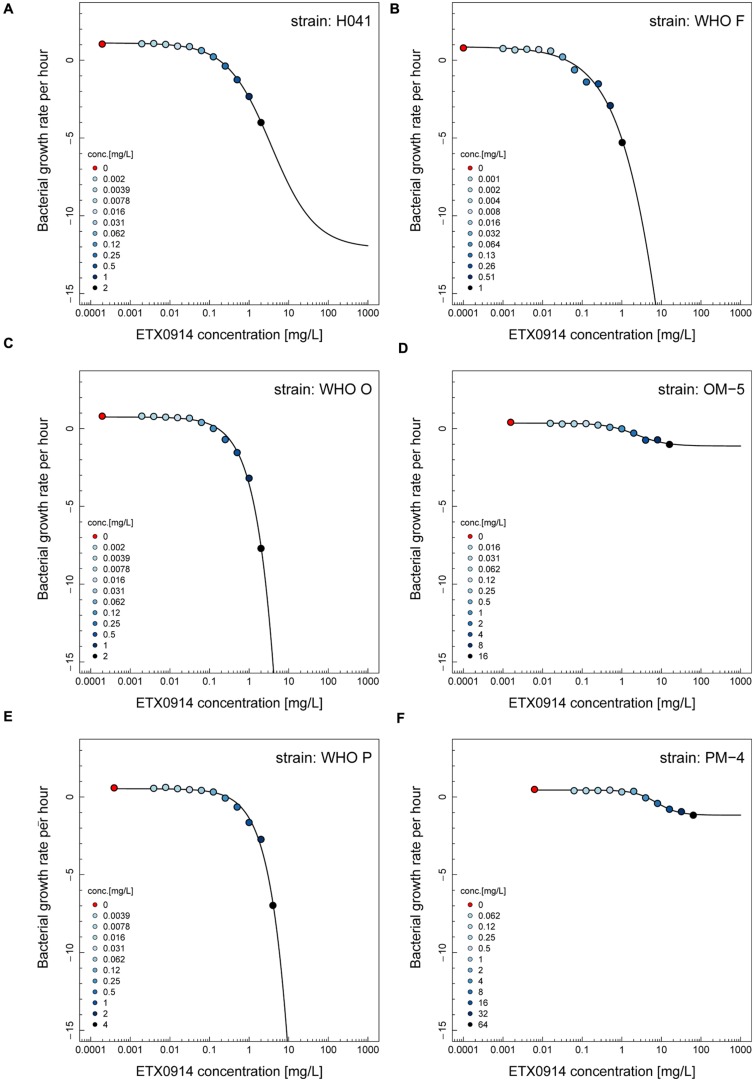
Pharmacodynamic functions based on the time-kill curve data for ETX0914 and six different Neisseria gonorrhoeae strains: H041 (A), WHO F (B), WHO O (C), OM-5 (D; in vitro selected resistant mutant from WHO O), WHO P (E), and PM-4 (F; in vitro selected resistant mutant from WHO P). The bacterial growth rates per hour derived from linear regression on time-kill curves for each ETX0914 concentration are plotted. Growth in absence of ETX0914 was plotted as a red circle, at a tenth of the lowest concentration to allow plotting on a log scale, and decreasing ETX0914 concentrations are shown from dark to light blue color.